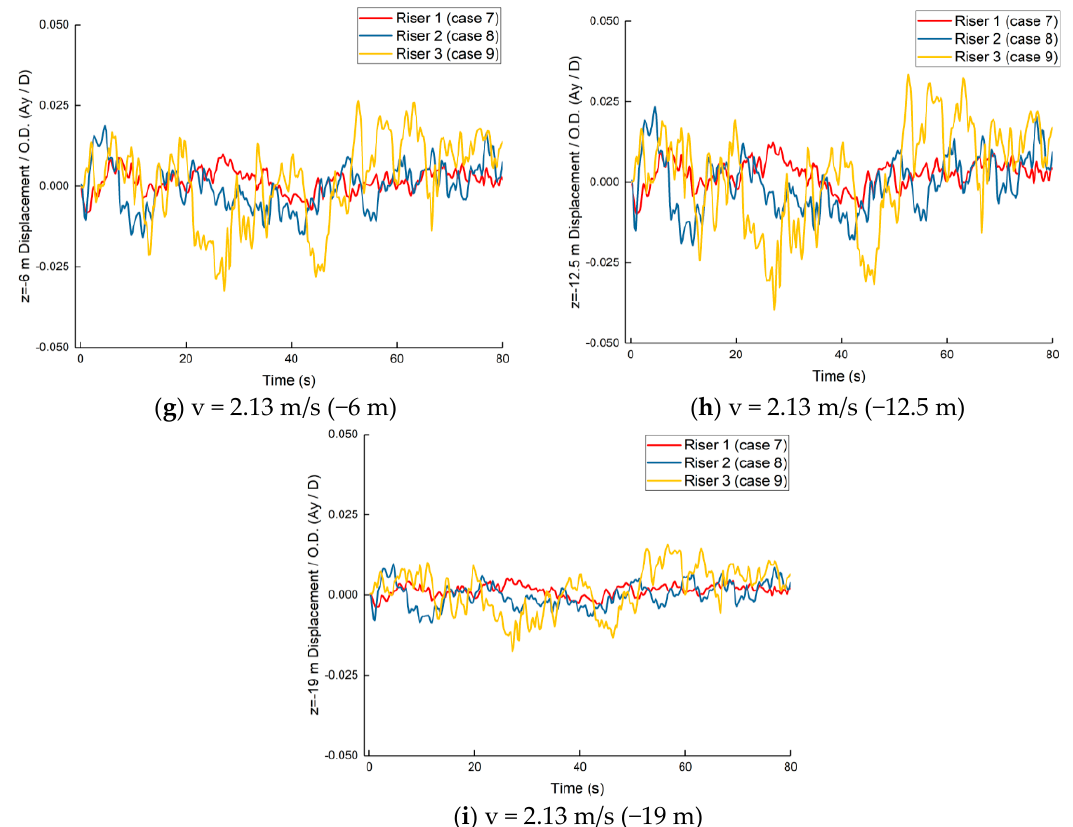
Figure 7. Time history of displacements in cross flow direction (Y) at three typical locations.